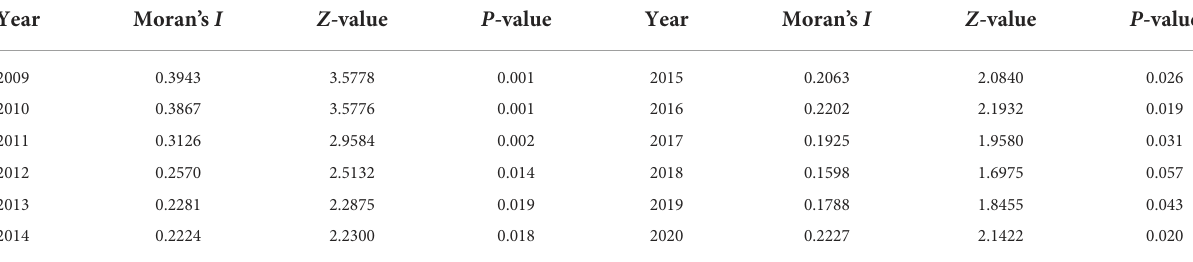
TABLE 5 Global Moran’s I index of health system efficiency in China from 2009 to 2020.